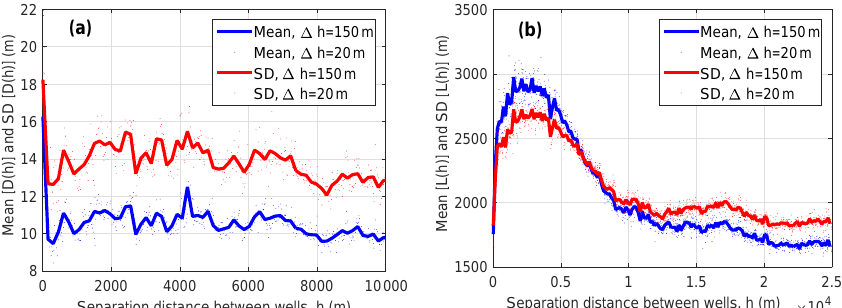
Figure 3. Mean and standard deviation as a function of separation distance h (m), sediment thickness D to the right (a) , and horizontal distance to outcrop L to the left (b)